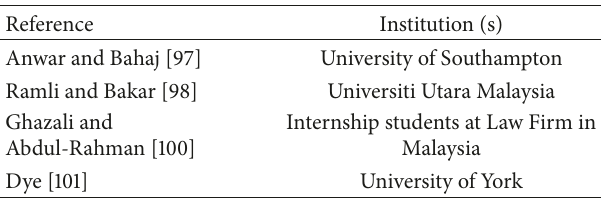
Table 11: Summary of real-world SPAP from different institutions.